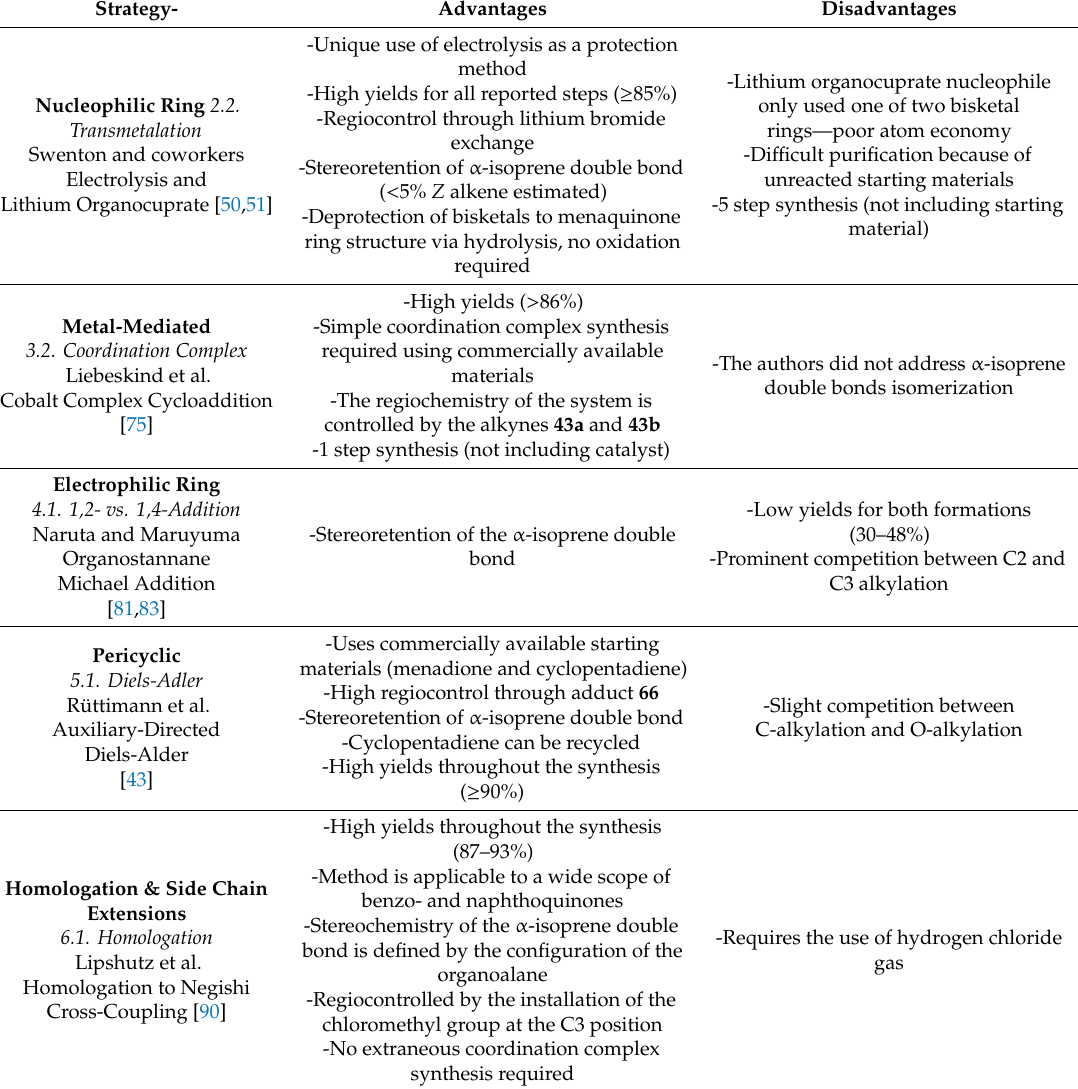
Table 10. Summary of the best reactions within each strategy to be compared to each other. Strategy-